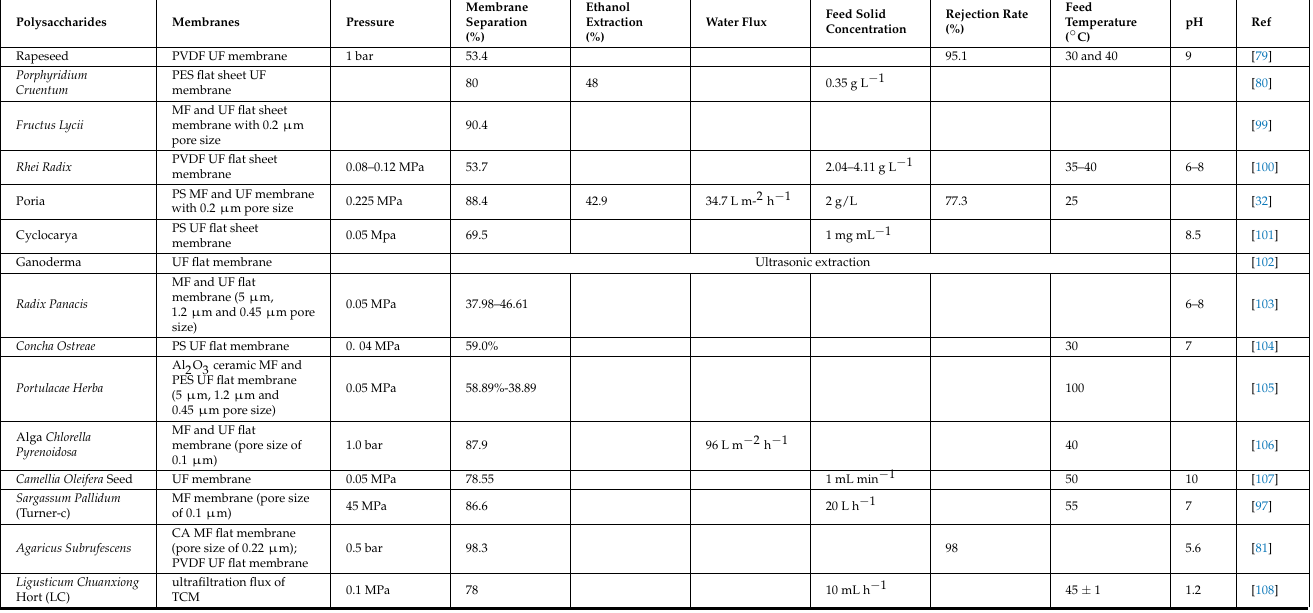
Table 4. Examples of polysaccharides filtration by membrane technology